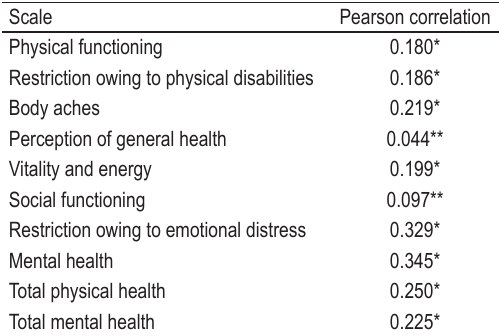
TABLE 6. Respondent satisfaction and quality of life (Mann–Whitney U